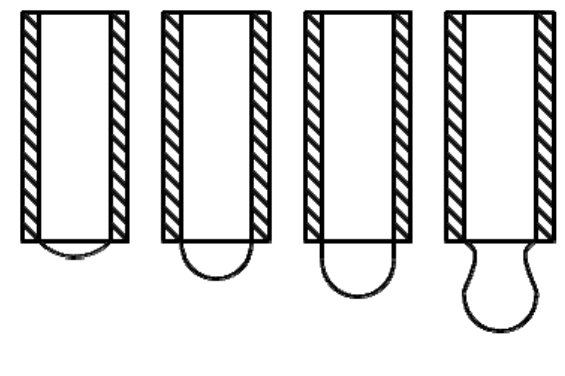
Figure 4. Stages of drop formation.